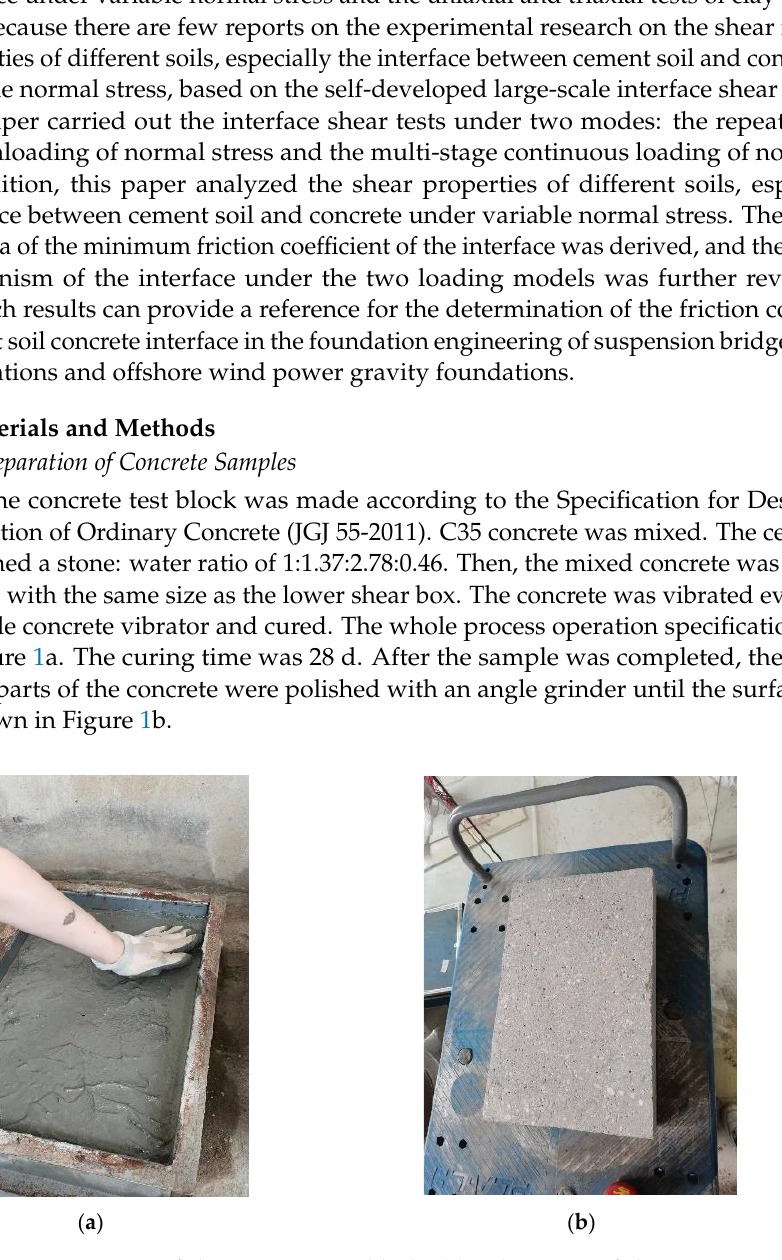
Figure 1. Preparation of the concrete test block: ( a ) Fabrication of the concrete test block and ( b ) Surface grinding of test block. ( b ) Surface grinding of test